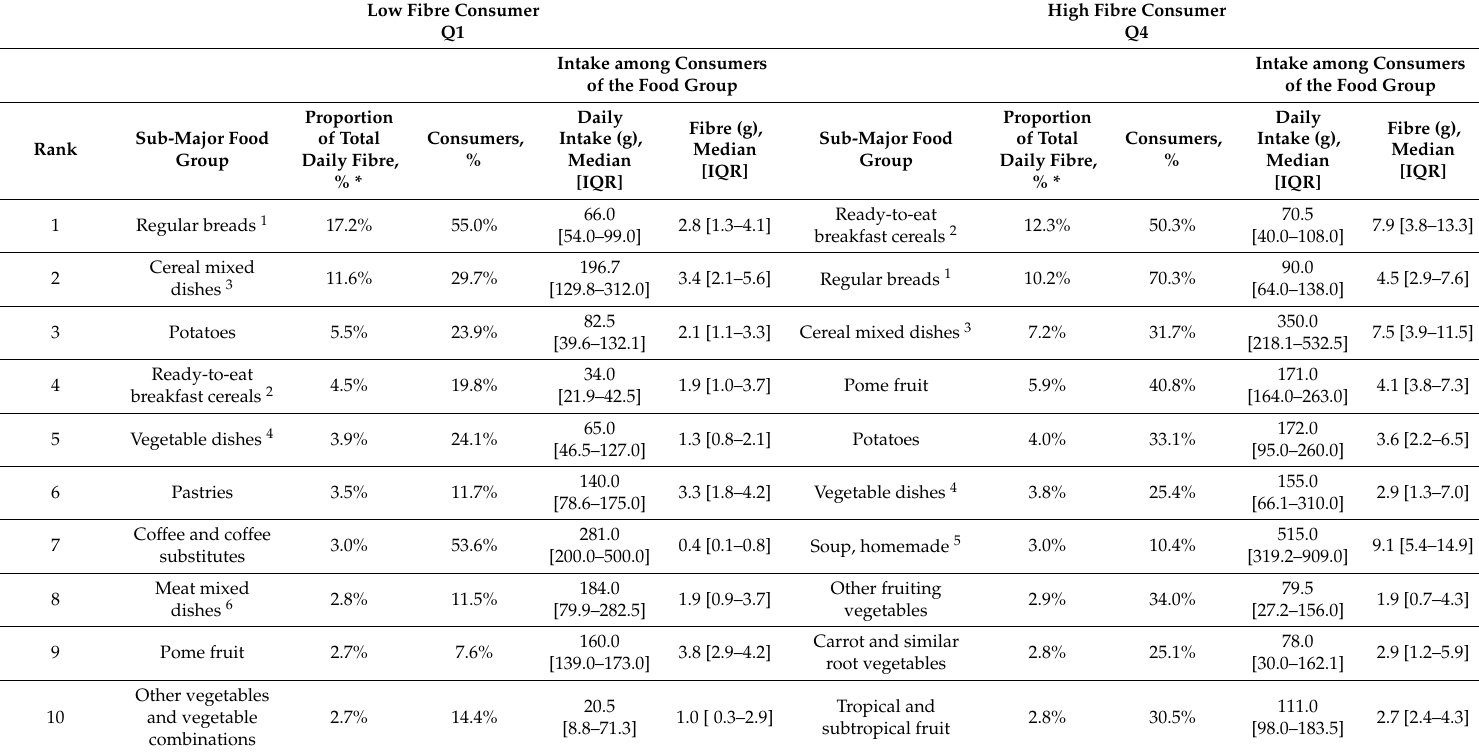
Table 4. Leading sub-major food groups by contribution to dietary fibre intake in adults aged 19 years and older. Low Fibre Consumer